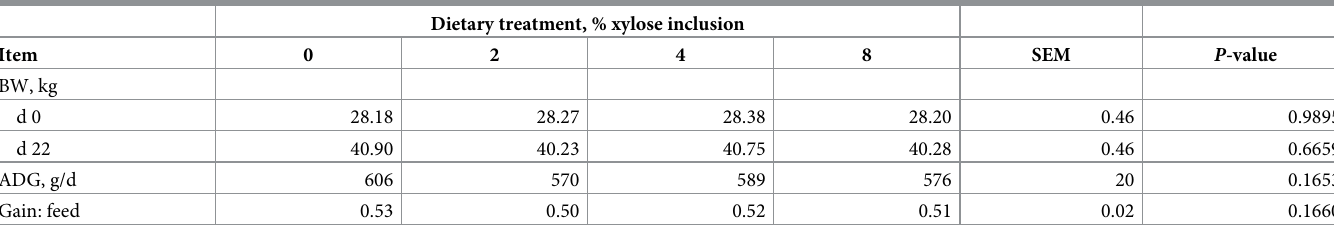
Table 3. Effect of dietary xylose concentration on pig growth performance. Dietary treatment, % xylose